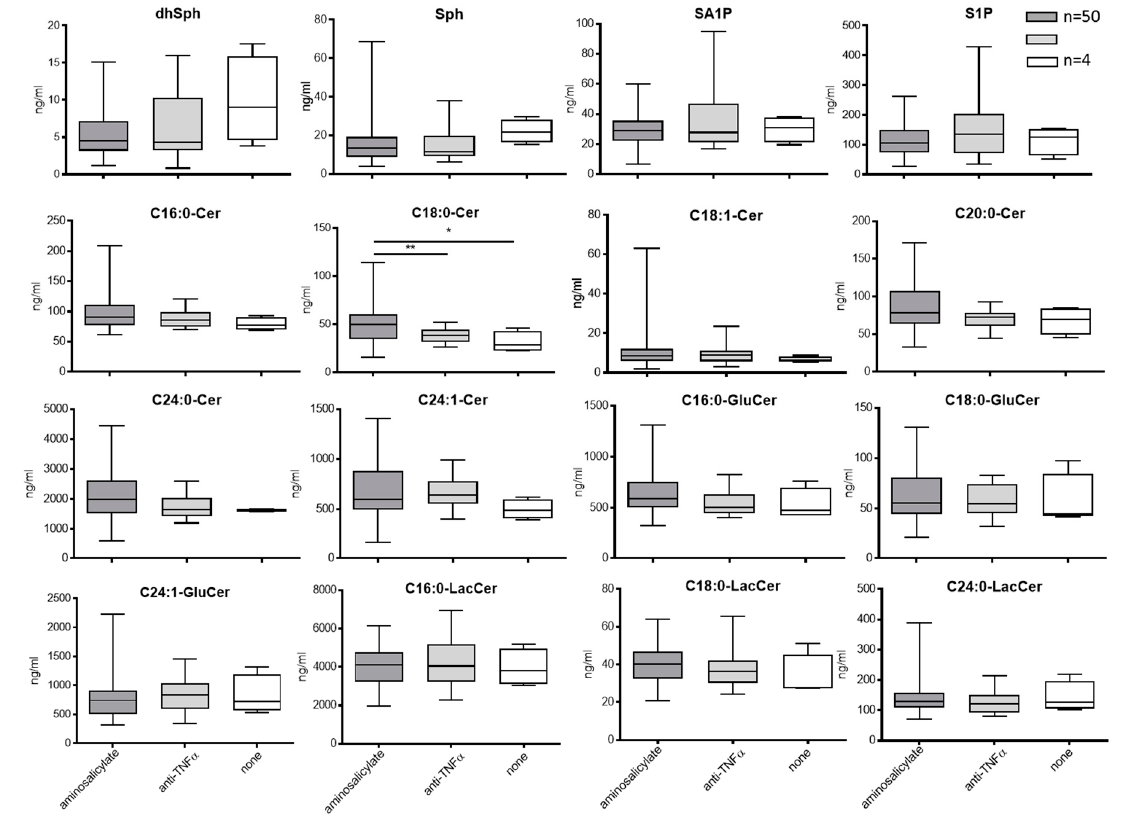
Figure 5. Sphingolipids in human plasma in relation to medical treatment. n none = 6; n anti TNF- α = 21; n aminosalicylate = 50. Statistical analysis was done with R, significant differences between groups were assessed using two-tailed ANOVA with Tukey multiple comparison, α = 0.05. (* p < 0.05, ** p < 0.01, *** p < 0.001).